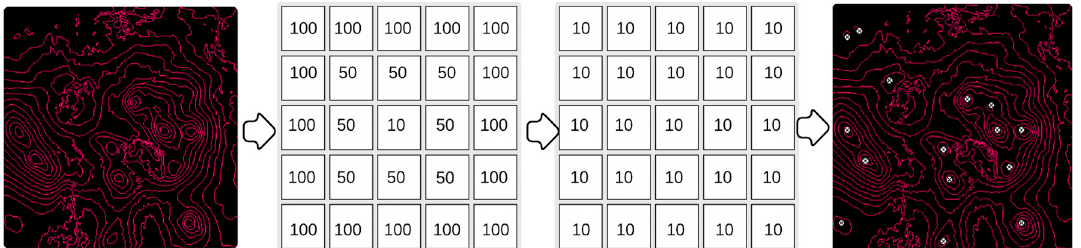
Figure 4. The process of potential cyclone eye identification using neighborhood analysis ( r = 5).